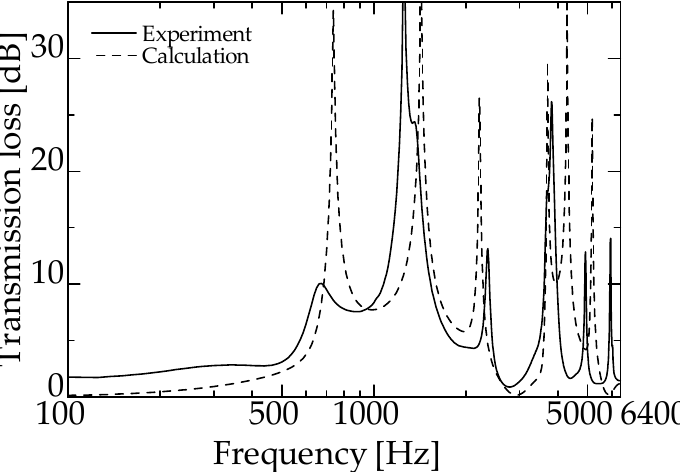
Figure 10. Experimental and theoretical values of the interference silencer with incorporated zero- mass metamaterial (zero-mass metamaterials installed at L da = 60 mm).